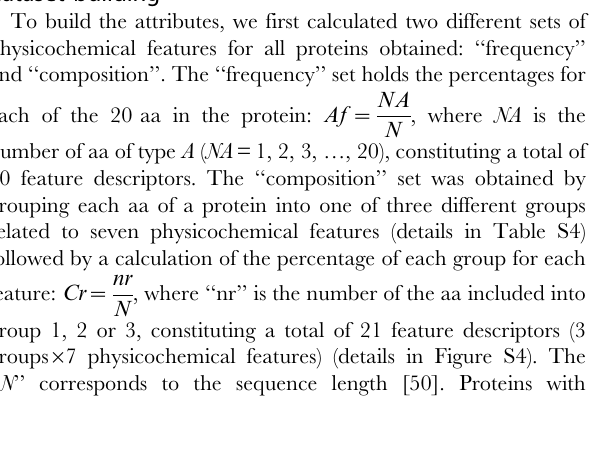
Classification using F Normal combined model